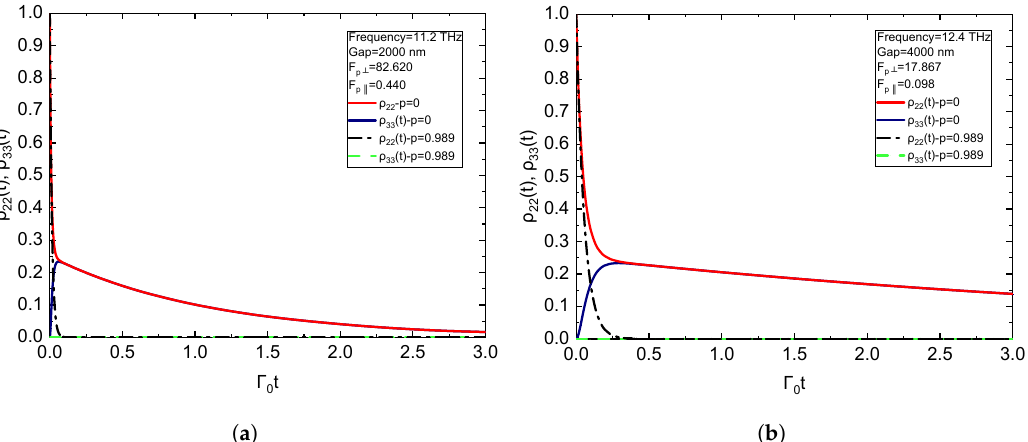
Figure 8. Population dynamics of states | 2 (cid:105) , | 3 (cid:105) in a dimer of Bi 2 Se 3 for ( a ) Gap = 2000 nm–11.2 THz, ( b ) Gap = 4000 nm–12.4